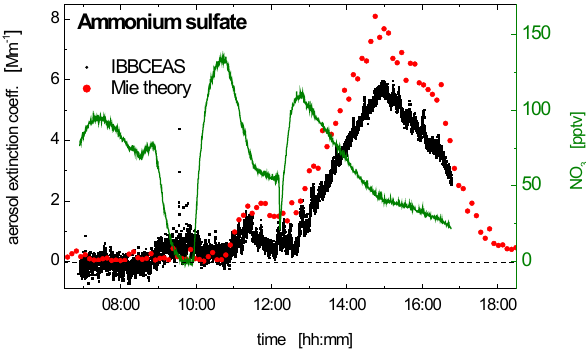
Fig. 1. Ammonium sulfate aerosol extinction coefficient on 15 June 2007 measured by the IBBCEAS instrument at 687nm (black dots) and calculated from the Mie theory (red dots) using the measured size distribution. Changes to the chamber composition